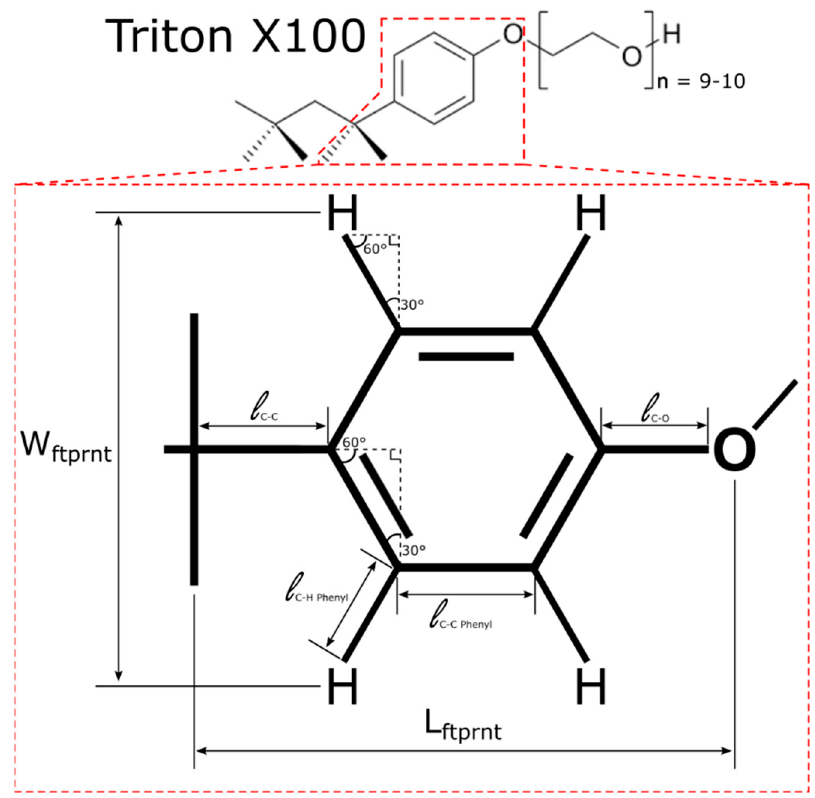
Figure 2. Assumed adsorbed footprint of Triton X011 molecule.